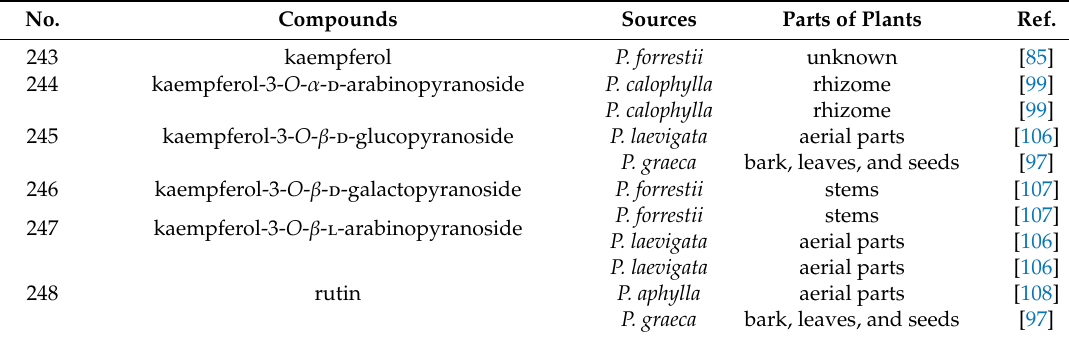
Table 6. Flavonoids from the genus Periploca .